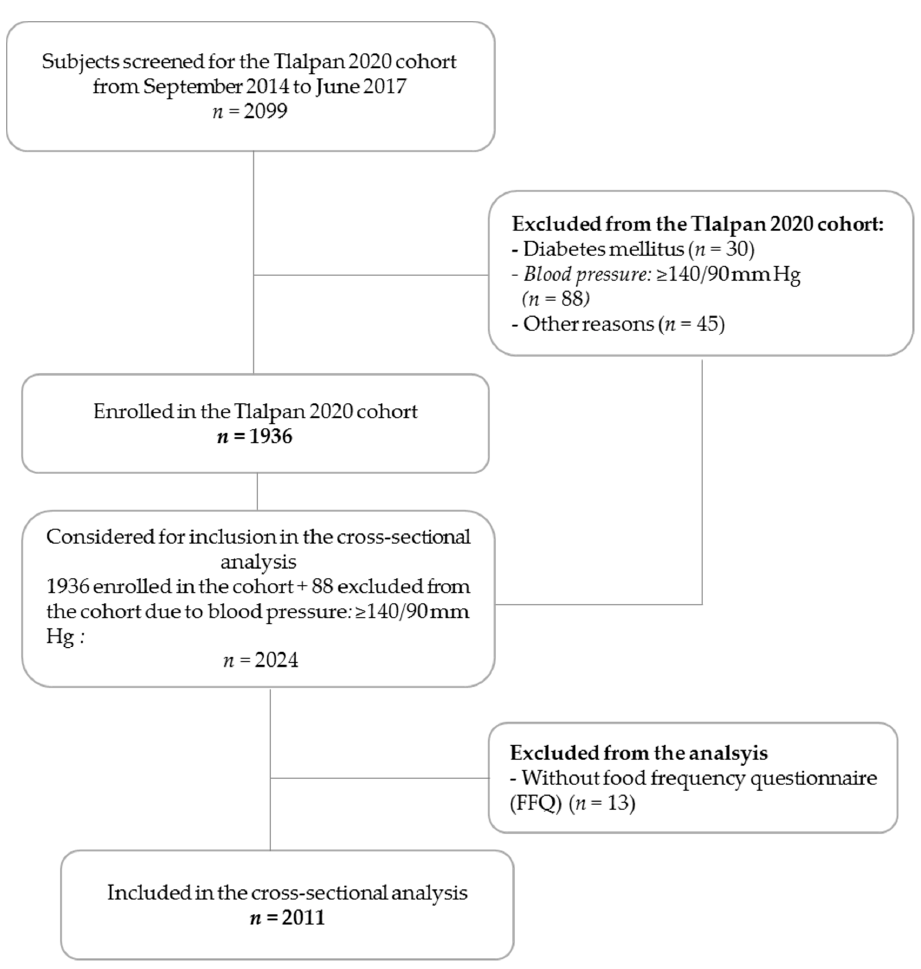
Figure 1. Participants flow